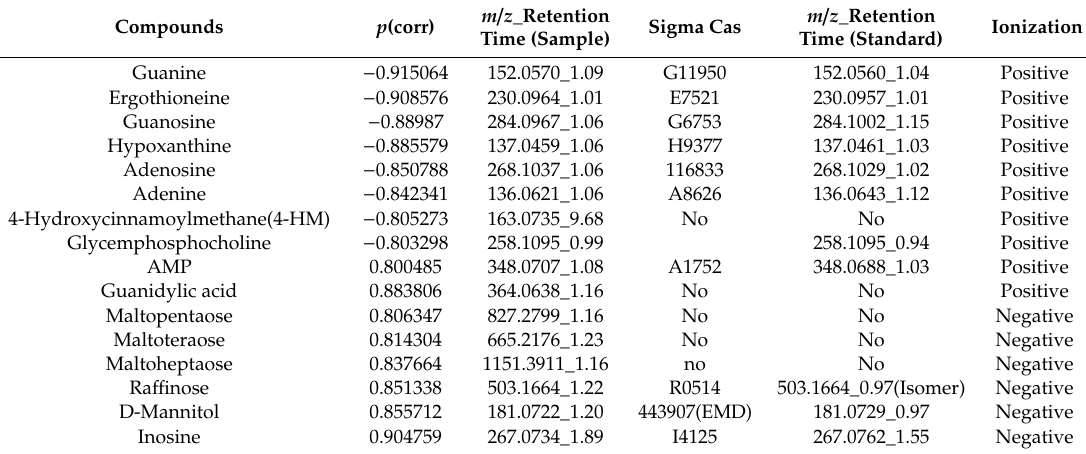
Table 2. Compounds identified by HPLC-MS / MS analysis from Beauveria bassiana -infected ants compared with Ophiocordyceps unilateralis -infected ants.